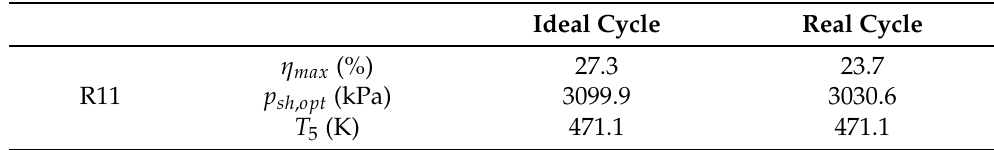
Table 3. Maximum performance ( η max ) , optimum super-heater pressure ( p sh , opt ) and output super- heater temperature ( T 5 ) for each working fluid under